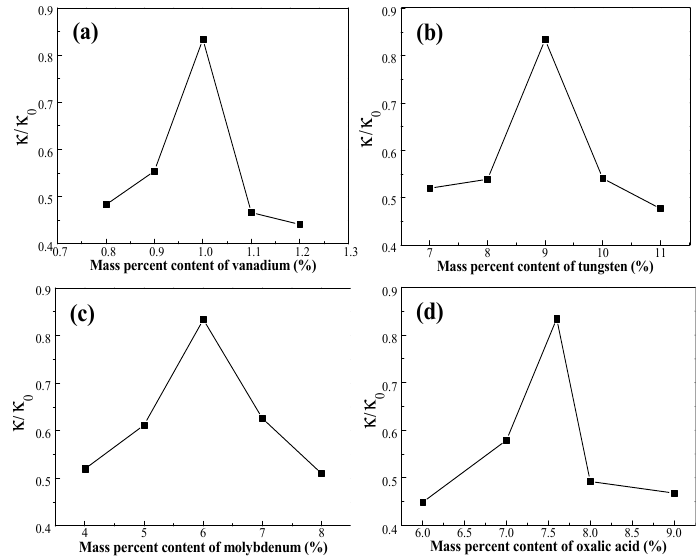
Figure 4. Effect of active ingredients on activity of the catalyst: ( a ) W = 9 wt %, Mo = 6 wt %, oxalic acid = 7.6 wt %; ( b ) V = 1 wt %, Mo = 6 wt %, oxalic acid = 7.6 wt %; ( c ) V = 1 wt %, W = 9 wt %, oxalic acid = 7.6 wt %; and ( d ) V = 1 wt %, W = 9 wt %, Mo = 6 wt %.